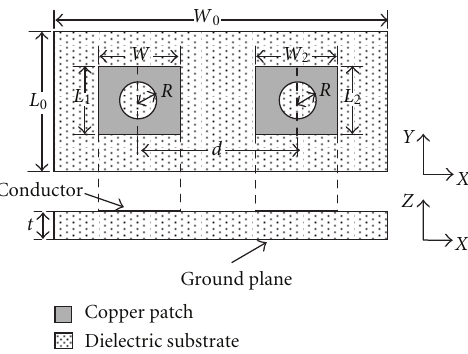
Figure 1: Geometry of a two patch element unit cell reflectarray ( L 1 = L 2 is length of patch, W 1 = W 2 is width of patch, R is radius of circular slot, L 0 and W 0 are the length and width of substrate, resp., t is thickness of substrate, and d is the interelement spacing).